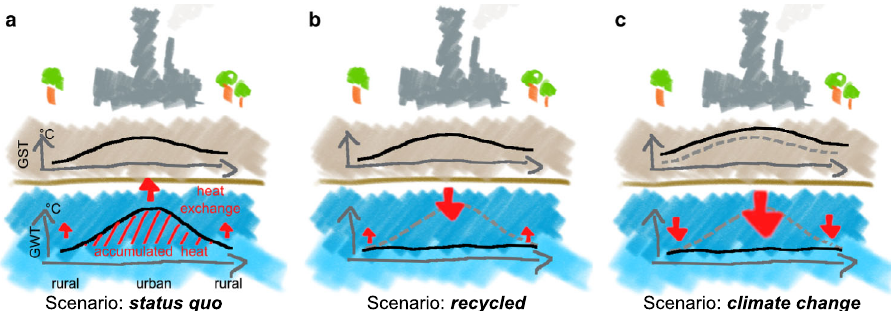
Fig. 1 Schematic drawing of the analyzed scenarios. a The status quo describes elevated groundwater temperatures (GWTs) under the built environment that result in accumulated heat (see Eq. (2)). b The recycled scenario highlights heat exchange (see Eq. (4)) between the surface and aquifer after the accumulated heat has been recycled and GWTs are restored to their undisturbed levels. c The impacts of climate change increase ground surface temperatures (GSTs) and thus impact the heat demand and the heat exchange between the surface and aquifer. We apply this scenario on top of the recycled